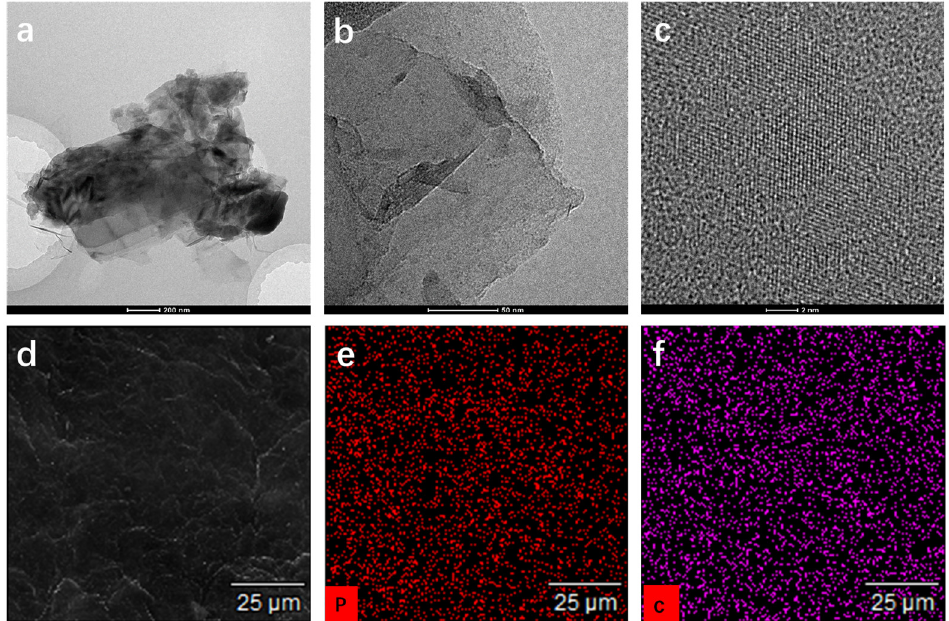
Figure 4. ( a ) TEM image of the BP/G composite materials; ( b ) enlarged TEM image of the BP/G composite materials; ( c ) HRTEM image of the BP/G composite materials; ( d ) SEM image of the BP/G composite materials; ( e ) phosphorus mapping of the BP/G composite materials; and ( f ) carbon mapping the BP/G composite materials.